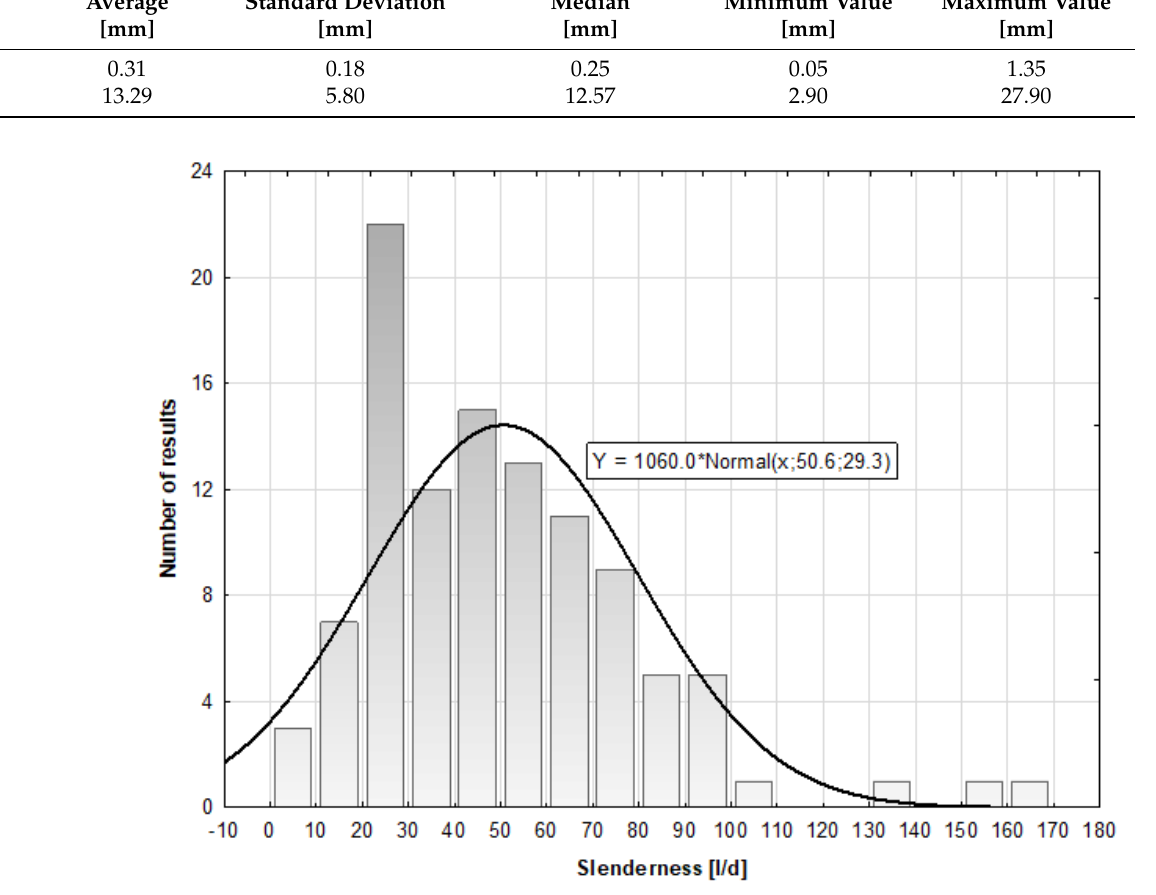
Figure 1. Slenderness of steel cord. The diameter of the majority of waste fibers (90%) is between 0.20 and 0.35 mm.